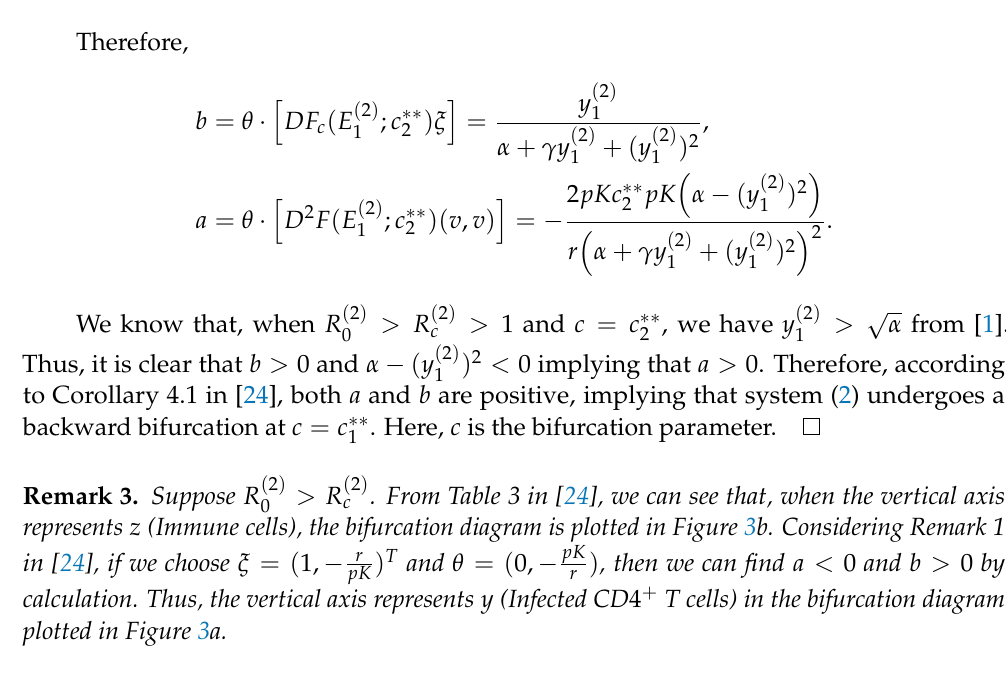
≈ 3.8333, and the bistable 2